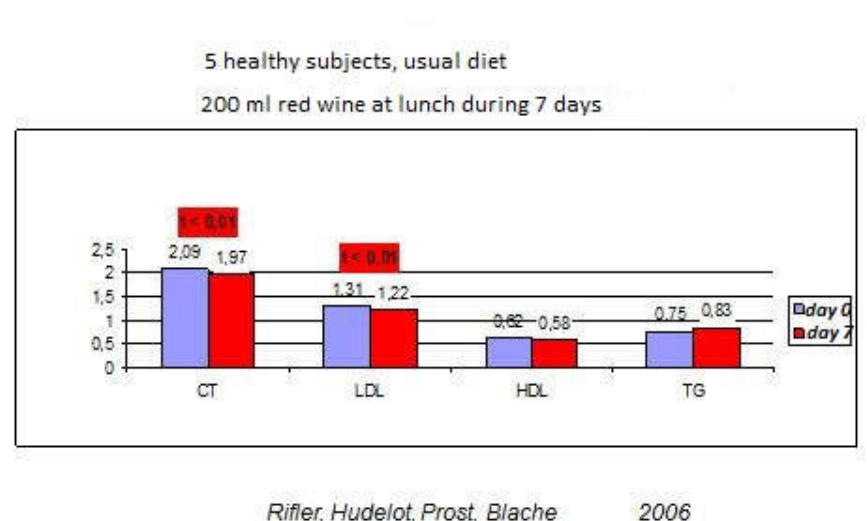
Figure 7. Lipid profile after 200 mL red wine ingestion at lunch. CT: Total cholesterol. LDL: Low density lipoprotein. HDL: High density lipoprotein. TG: Triacyl glycerol.